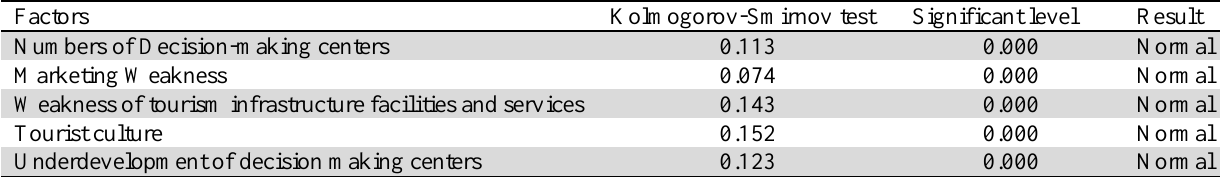
The summary of Kolmogorov- Smirnov test